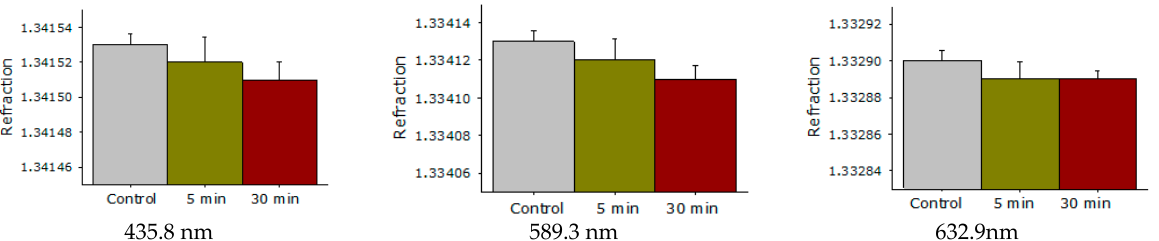
Figure 7. Effect of laser irradiation time on the refractive index of aqueous solution of BSA at wavelengths of 435.8 nm, 589.3 nm, 632.8 nm. Data obtained using precision refractometry ( n = 3, Mean ± SD).